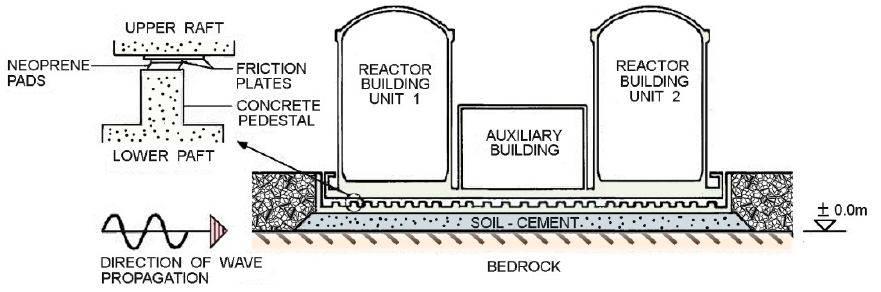
Figure 5. Placement of isolation system at Koeberg NPP [17].